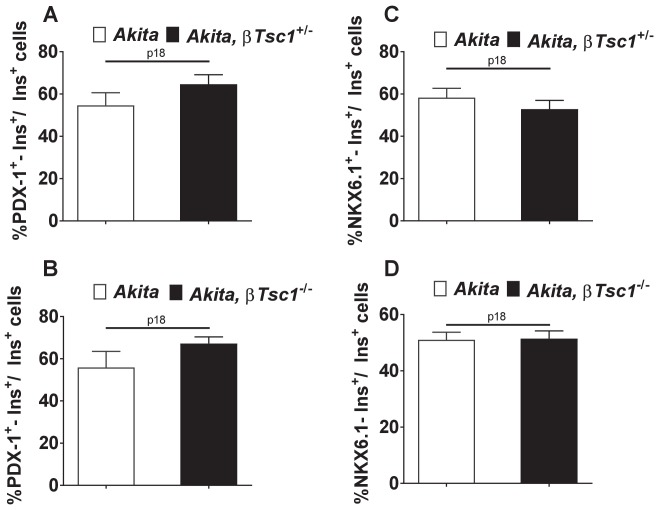
Effects of mTORC1 activation in Akitaβ-cells on PDX-1 (a, b) and NKX6.1 expression (c, d).Heterozygous (a, c) and homozygous (b, d) βTsc1 knockout Akita and age-matched controls were sacrificed at P18. Pancreatic sections were stained for insulin and PDX-1 (Akita (n = 1760 β-cells); Akita, βTsc1+/- (n = 814 β-cells); Akita, βTsc1-/- (n = 1458 β−cells) or NKX6.1 (Akita (n = 1500 β-cells); Akita, βTsc1+/- (n = 1438 β-cells); Akita, βTsc1-/- (n = 1584 β-cells).